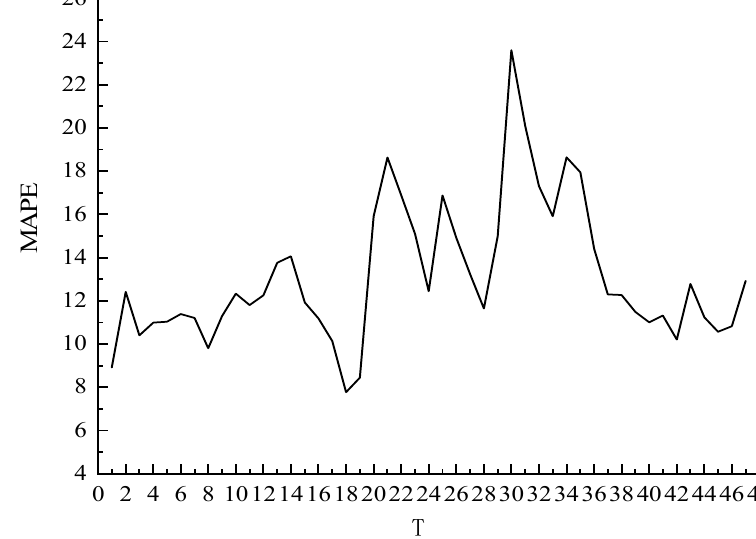
The average absolute percentage error ( MAPE ) of the prediction results for different T values is obtained by averaging the 48 time period MAPE values corresponding to the 47 T values of T [1, 47], as shown in Figure 3 below.